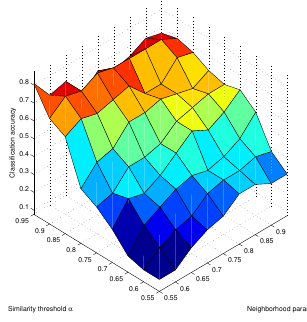
Figure 3. Classification accuracy for the segmentation dataset.